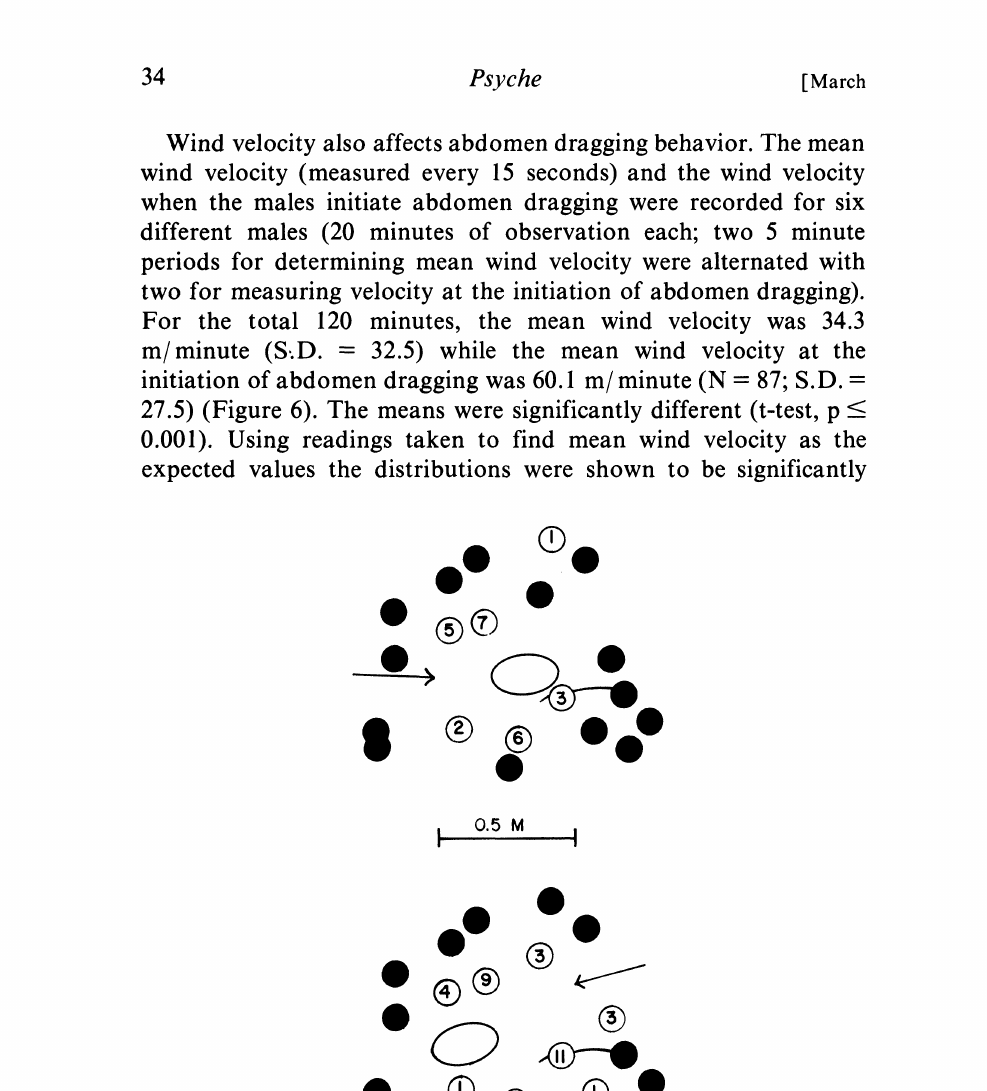
Figure 5. The effect of wind direction on position of the scent-marked plants for territory K (see Figure 2). Solid arrow indicates wind direction which on different days may come from different directions. Solid circles are plants not scent marked. Hollow circles are marked plants with the number of times it was marked in 10 (above) and 15 (below) minutes. The ellipse is where the male perched on the